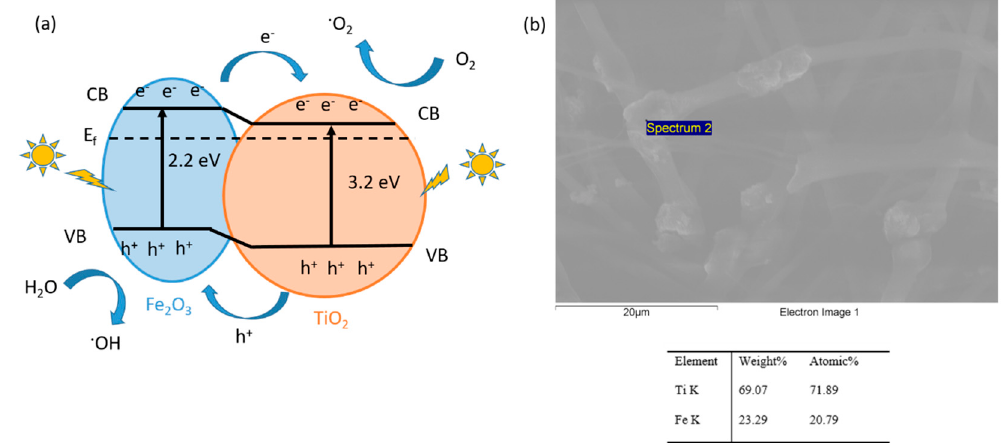
Figure 12. ( a ) Schematic diagram of the photocatalytic mechanism; ( b ) SEM image with EDX mapping in the selected area indicating the presence of both types of nanoparticles for the heterojunction mechanism.